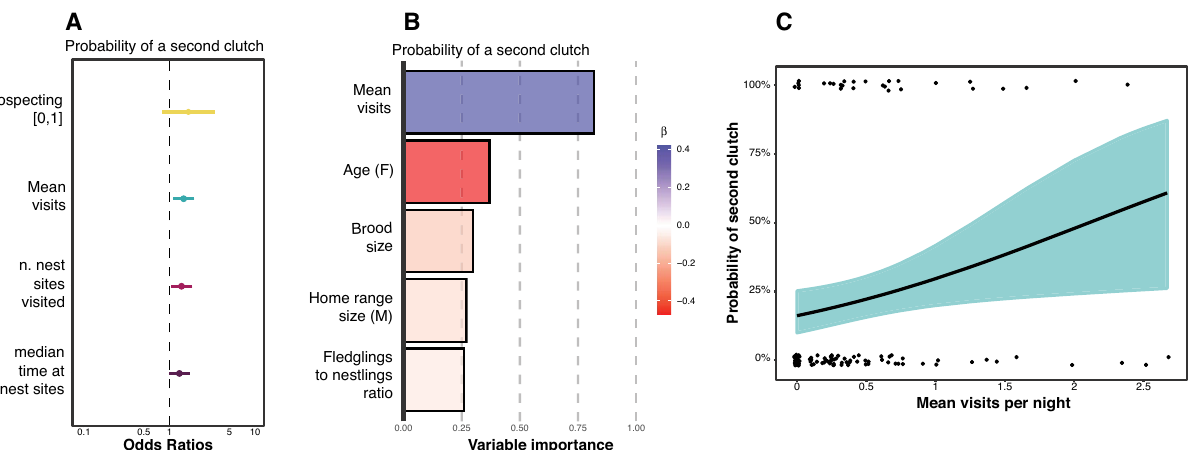
Figure 4. Set of univariate model results (estimated coefficient with 95% confidence interval ranges) with prospecting parameters as predictors of the possibility of having a second clutch by female barn owls, colours are just to visually discriminate the variables ( A ). Summary of variable importance and model coefficients of averaged model ( B ), length of the bar is relative to variable importance (sum of Akaike weights – Σw i ), colour is relative to the standardised effect direction (red = negative, blue = positive) and its intensity is proportional to the effect strength. Predicted effect of mean visits per night ( C ) from averaged model in ( B ) on the probability of re-nesting for the second time in female barn owls, coloured area around the regression line is relative to 95% confidence intervals and linked to colour of the same variable in ( A